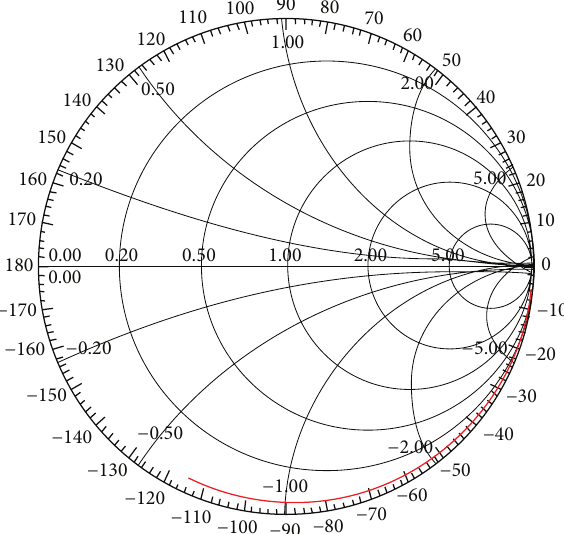
Figure 7: Measured reflection coefficients of a test car tire.